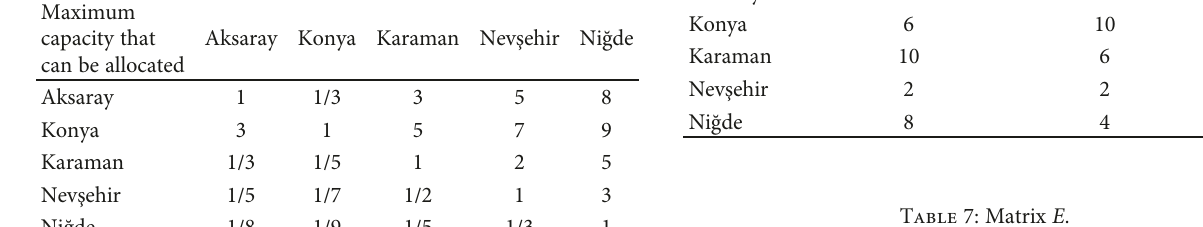
Table 4: Comparison matrix for maximum capacity that can be allocated.